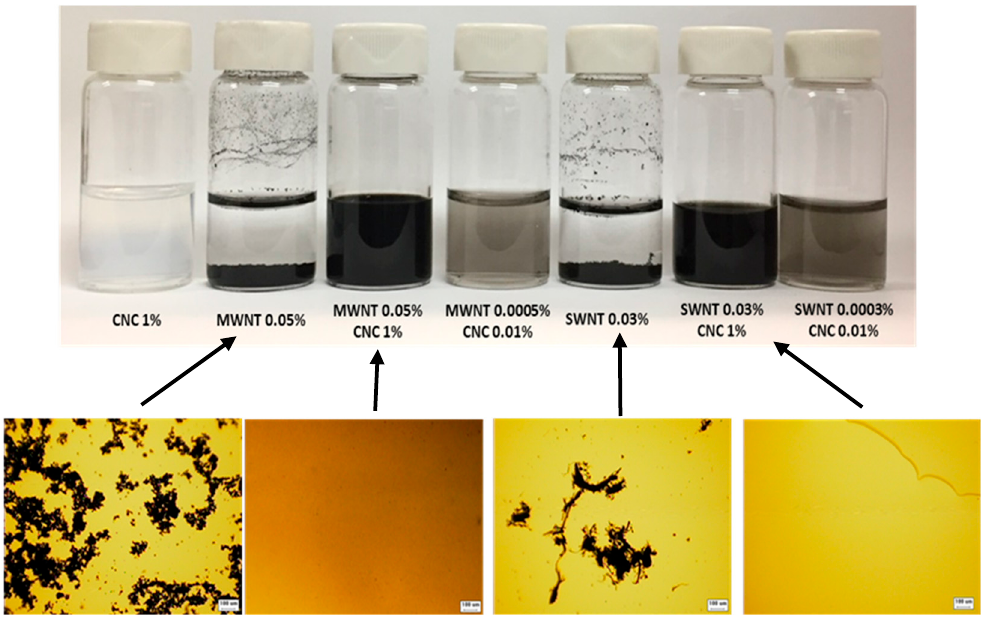
Figure 1. Vials (6 mL) containing aqueous dispersions of (left to right) cellulose nanocrystals (CNC) 1%, multiwall carbon nanotubes (MWNT) 0.05% at pH = 3.1, MWNT 0.05% and CNC 1%, MWNT 0.0005% and CNC 0.01%, single-wall carbon nanotubes (SWNT) 0.05% with pH = 3.1, SWNT 0.05% with CNC 1%, and SWNT 0.0005% with CNC 0.01%. All samples were imaged after sitting for 6 weeks. Optical microscope images of coordinating dispersions are shown below to demonstrate dispersion. Scale bar: 100 μ m.